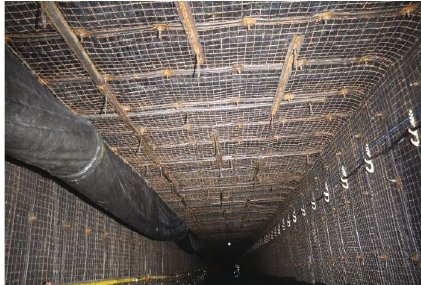
Figure 18: Roadway surrounding rock control e ff ect.